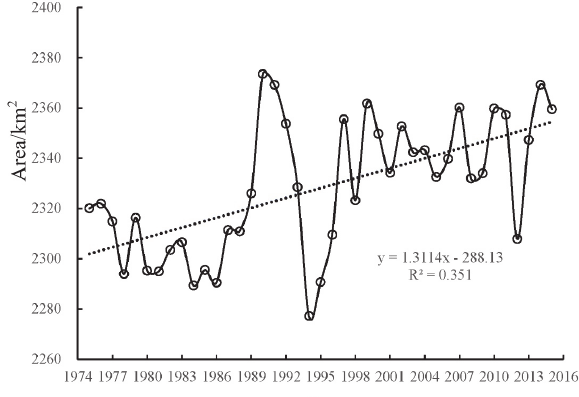
Figure 2. The estimated surface area time-series during 1975- 2015 from Landsat of Taihu Lake